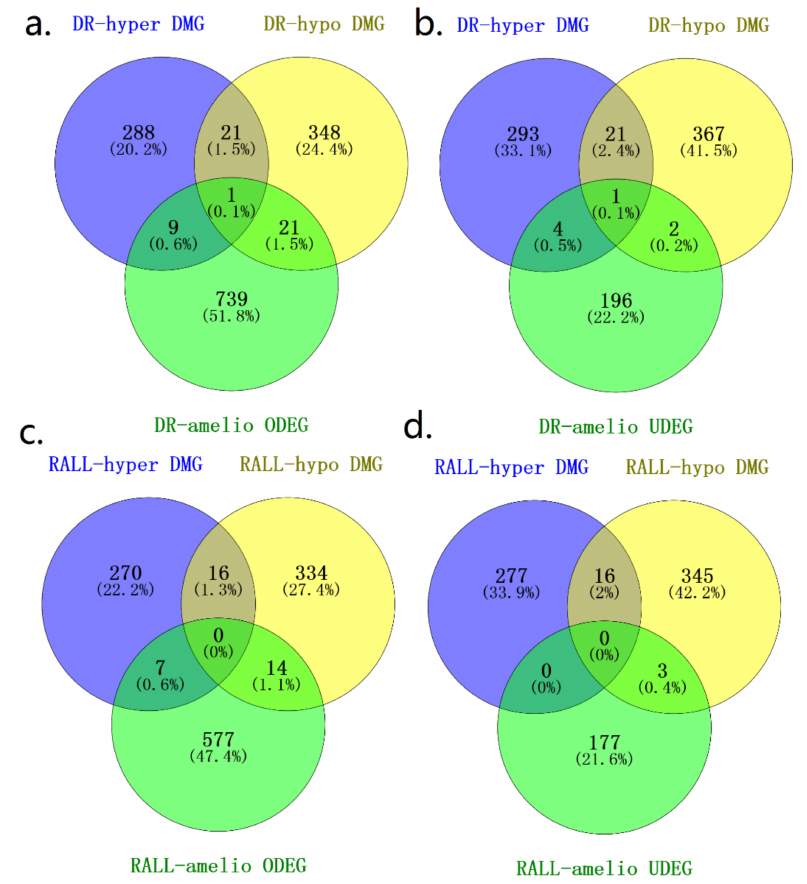
Figure 5. Overlap genes between DMGs and DEGs. ( a ) overlap genes between DR-ameliorated ODEGs and DR-amliorated DMGs; ( b ) overlap genes between DR-ameliorated UDEGs and DR- amliorated DMGs; ( c ) overlap genes between RALL-ameliorated ODEGs and RALL-amliorated DMGs; ( d ) overlap genes between RALL-ameliorated UDEGs and RALL-amliorated